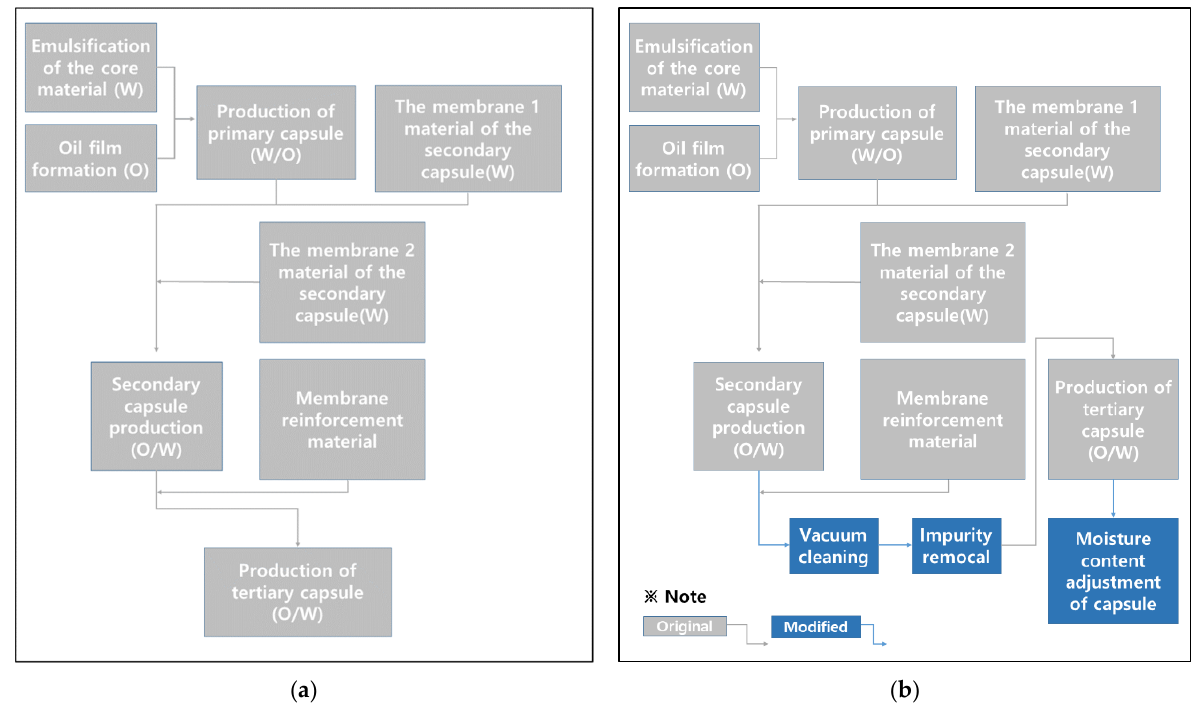
Figure 3. Encapsulation process of MCs: ( a ) original method; ( b ) improved method.